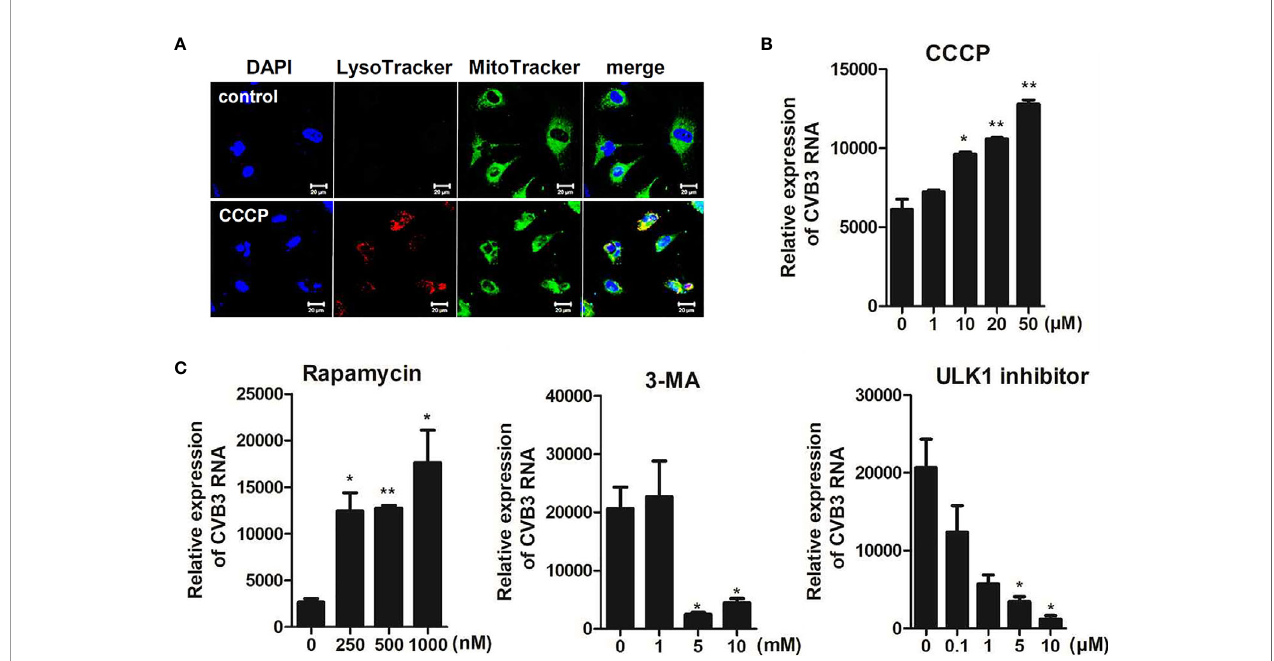
FIGURE 6 | CCCP-mediated activation of mitophagy facilitates CVB3 replication in hNPCs (A) hNPCs were treated with 25 m M CCCP for 2 h, and cells were subsequently stained with LysoTracker Red and MitoTracker Green. Scale bar = 20 m m. (B) hNPCs were pre-treated with different doses of CCCP for 2 h and infected with CVB3 at an MOI of 5 for 48 h. CVB3 RNA copy number was quantitated, normalized, and analyzed by quantitative realtime PCR (mean ± SD; n = 3). (C) hNPCs were treated with rapamycin (autophagy inducer), 3-MA (autophagy inhibitor), or ULK1 inhibitor (SBI-0206965) for 2 h at various concentrations and infected with CVB3 at an MOI of 5 for 48 h. CVB3 RNA copy number was quantitated, normalized, and analyzed by quantitative realtime PCR (mean ± SD; n = 3). *p < 0.05; **p < 0.01, vs . DMSO-treated